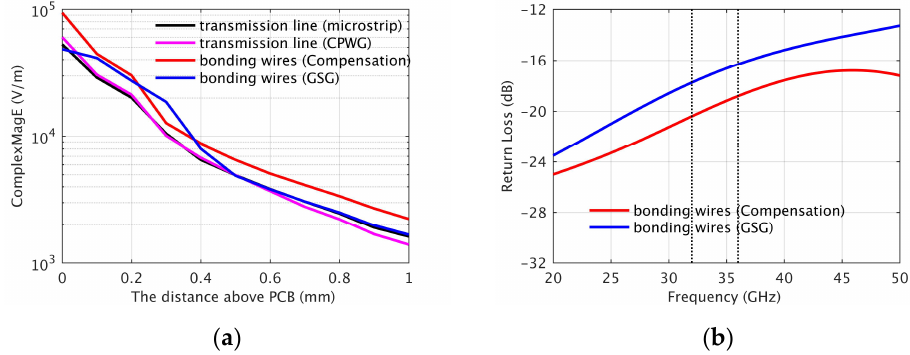
Figure 16. ( a ) Comparison of spatial radiation of different transmission lines and bonding lines. ( b ) Return loss of bonding lines .